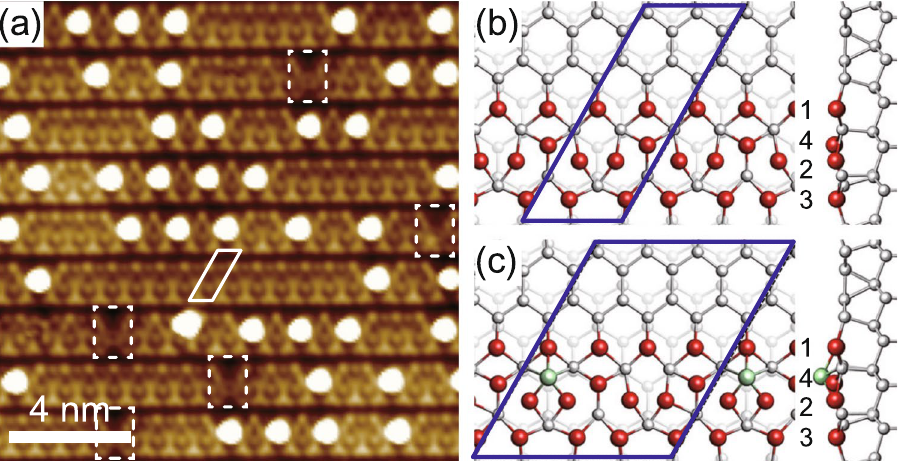
Figure 1. ( a ) Topographic STM image (15 × 15 nm 2 ) of Si(111)5 × 2-Au at 78.2 K. Bright protrusions are Si adatoms formed inevitably during surface preparation. Bias voltage and tunneling current are − 1.0 V and 300 pA. A 5 × 2 unit cell (solid lines) and atomic-scale dislocations 19 (dashed lines) are indicated. KK 26 models for the ( b ) adatom-free and ( c ) 0.05 monolayer Si adatom (4 a 0 chain) surfaces. Au (Si) atoms are represented by large (small) balls. Different Au atomic rows are indicated as